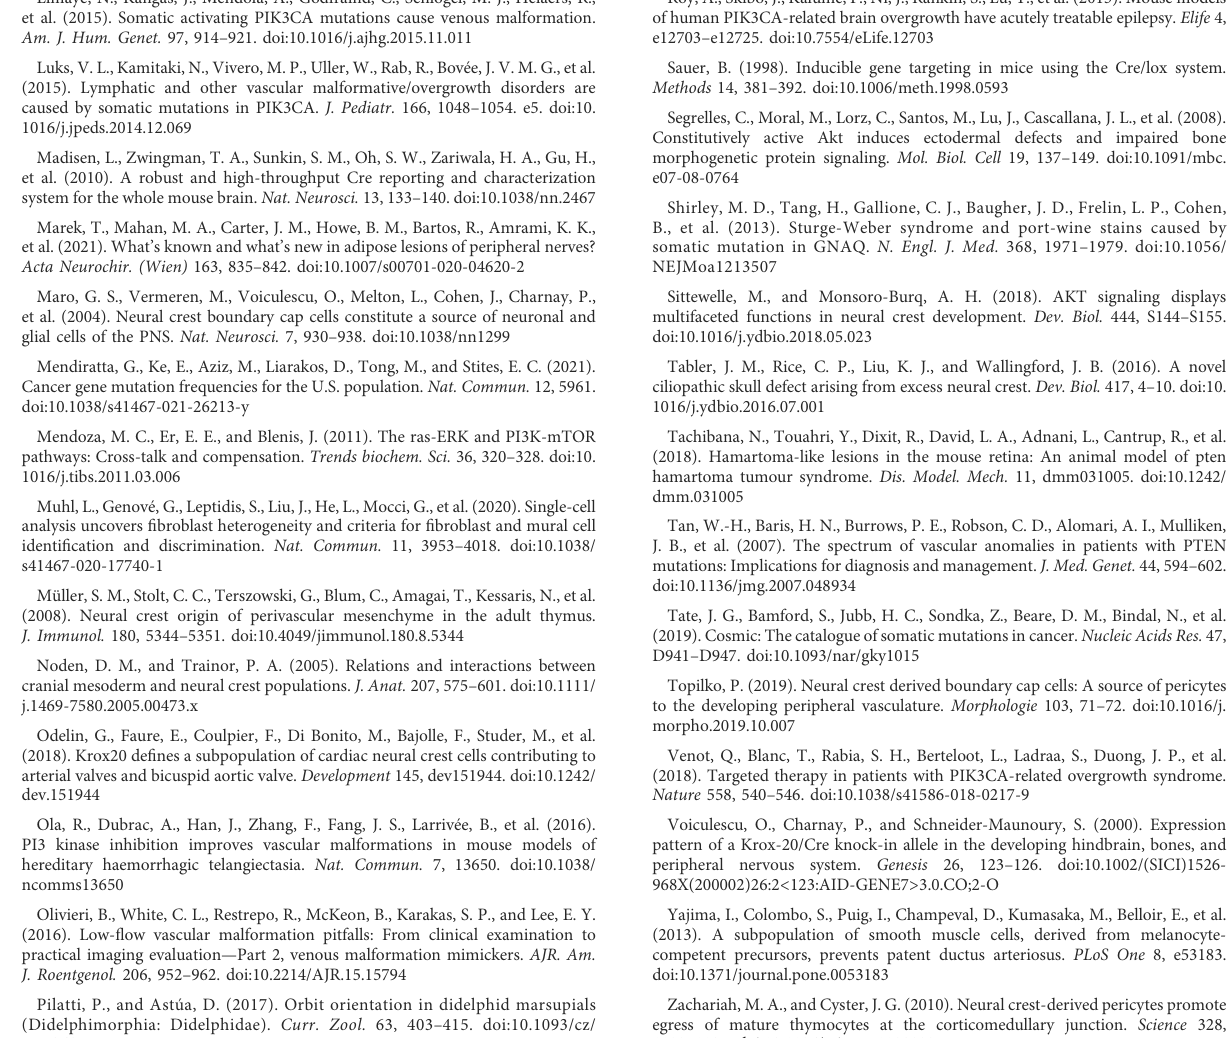
Tabler, J. M., Rice, C. P., Liu, K. J., and Wallingford, J. B. (2016). A novel ciliopathic skull defect arising from excess neural crest. Dev. Biol. 417, 4 – 10.